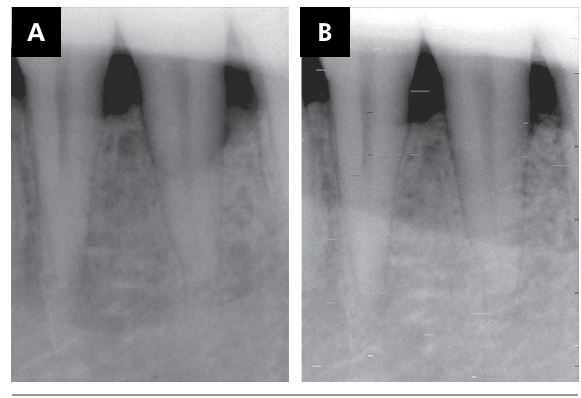
Figure 3. Test group: (A) periapical radiograph of the intra-bony defect at baseline; (B) periapical radiograph of the intra-bony defect at 6 months after ABBM-PRF combination treatment.